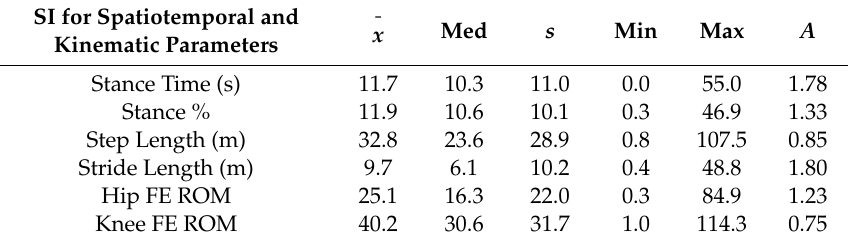
Table 2. SI for six gait parameters.